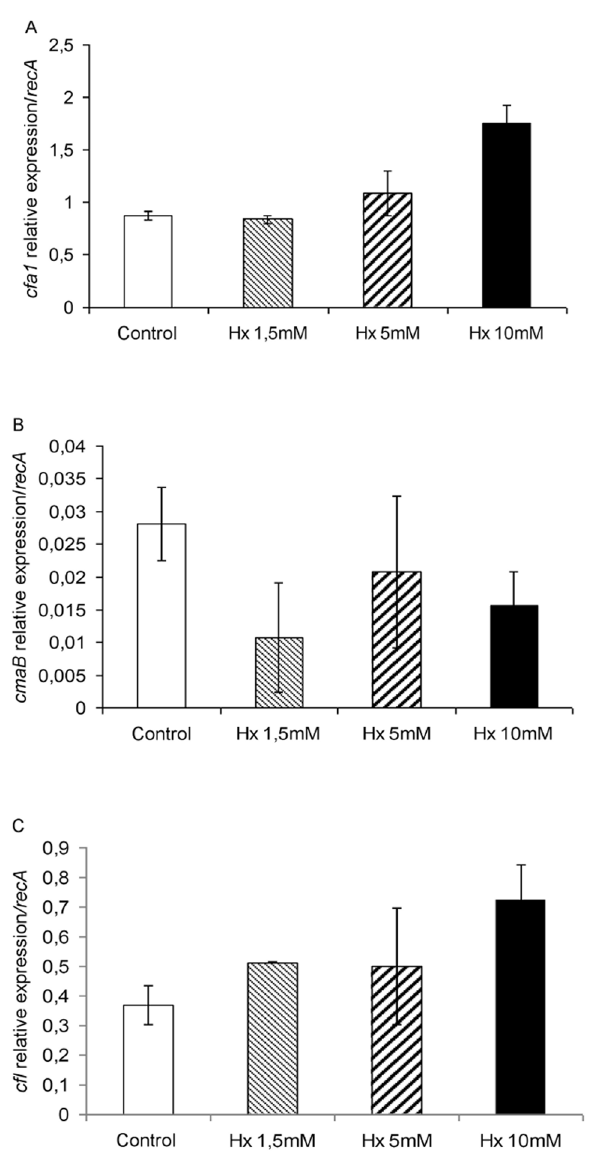
Figure 4. Relative expression of COR synthesis genes ( cfa1 (A), cmaB (B), and cfl (C)) during bacterial growth in the presence of different Hx concentrations. Template cDNAs were generated from the total RNA extracted from bacteria grown as described in Figure 3. The recA gene was used as an endogenous reference gene. The results represent the means and standard deviation from three different experiments.